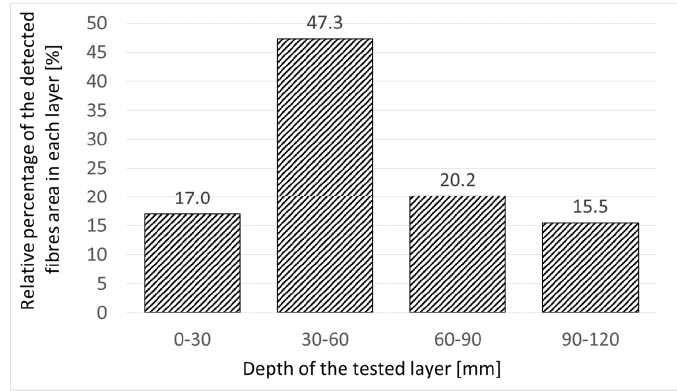
Figure 4. Relative percentage of the detected fibre at each scanned depth.